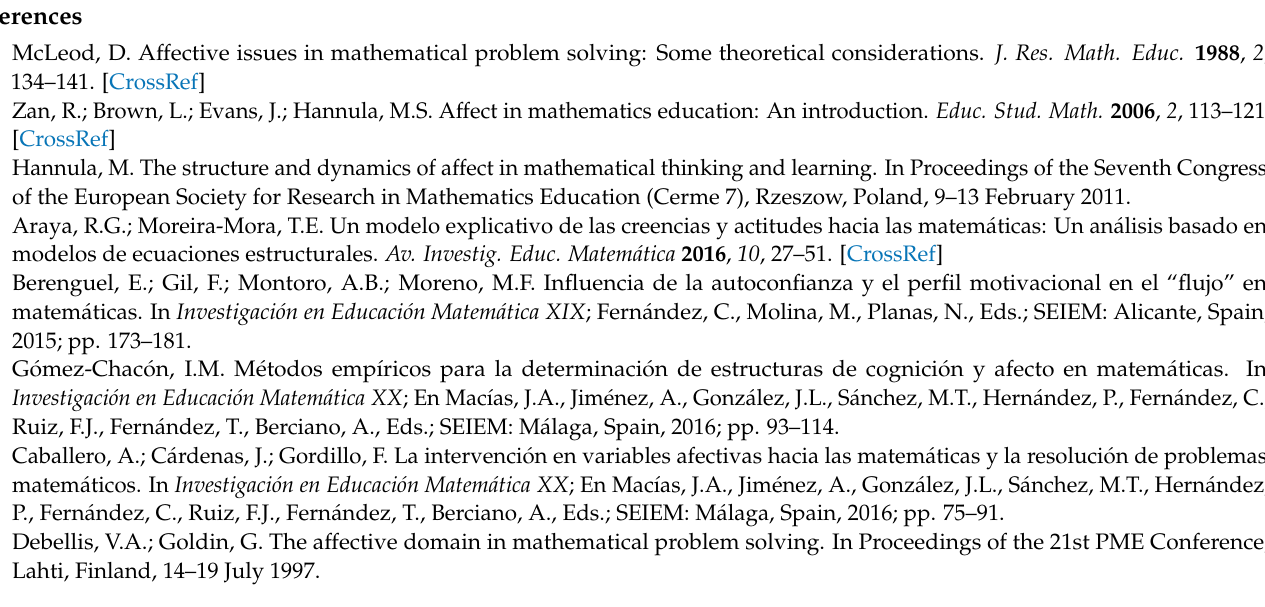
Figure A1. First two cases for the sequence of squares built with matches. Source: authors. TANGENT OF THE COMPLEMENTARY The two angels of a right triangle are called complementary because their sum is 90 degrees. What is the complementary of 10 degrees? What relationship is there between the tangent of the angle and the tangent of the complementary?